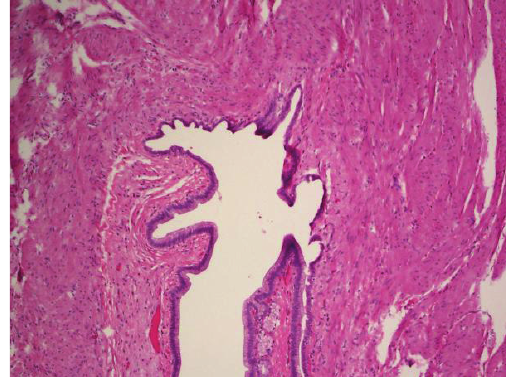
Figure 5: Photomicrograph: cyst wall was composed of mucosa, submucosa, and muscularis propria. Mucosa was predominantly of gastric type with small islands of pancreatic